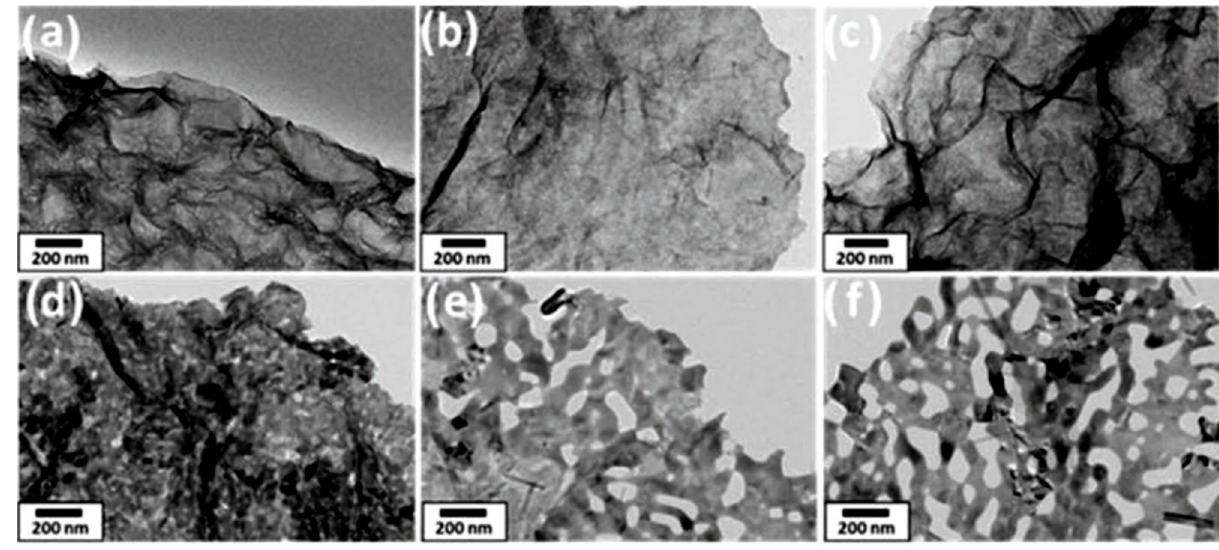
8 of 33 Figure 5. Nanostructure evolution mechanism. SEM images of ( A ) K ‐ titanate, ( B ) H ‐ titanate, and ( C ) porous single ‐ crystalline TiO 2 , respectively. ( D ) Schematic illustration of converting K ‐ titanate to porous single ‐ crystalline TiO